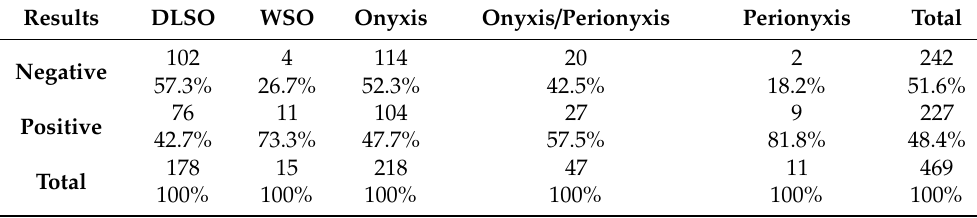
Table 5. Frequency of onychomycosis based on the clinical characteristics of the lesions.